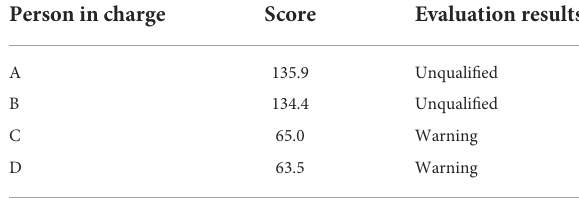
TABLE 9 Evaluation results of 2021 annual scoring for physicians and medical